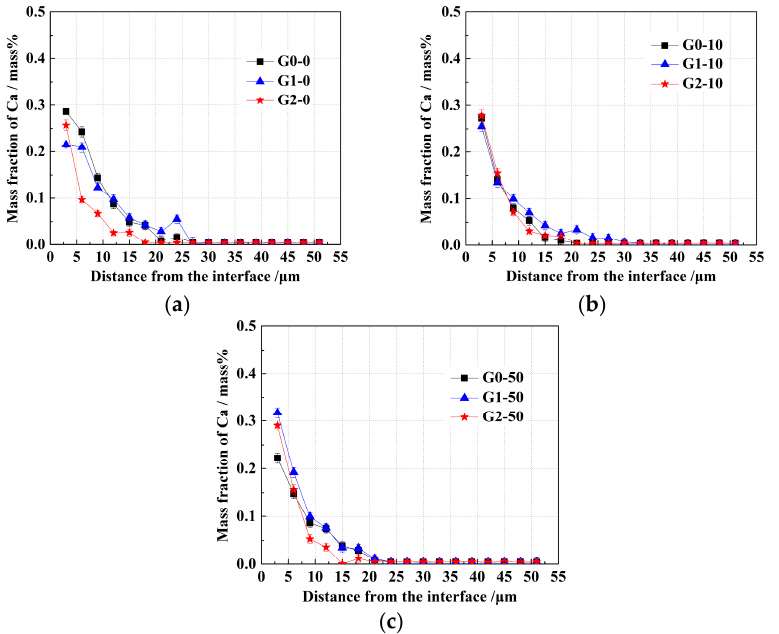
Figure 9. Effect of FeO content in the oxide on Ca content in the alloy of diffusion couple G0, G1, and G2 before and after heat treatment at 1473 K: ( a ) after oxide pre-melting experiment; ( b ) after heat treatment for 10 h; ( c ) after heat treatment for 50 h.